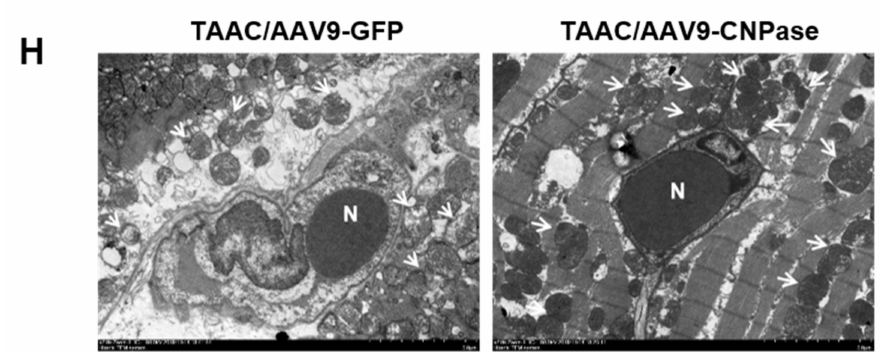
Figure 4. Myocardial CNPase delivery protects the heart from pressure overload-induced cardiomy- opathy. ( A , B ) Effects of CNPase overexpression on the heart weight to body weight (HW/BW) ratio and the heart weight to tibia length (HW/TL) ratio. ( C – E ) Effects of CNPase overexpression on the heart hypertrophy and cardiomyocyte size. Representative images of heart cross sections by hematoxylin and eosin (H and E) staining and quantitative analysis. Original magnifications, D Â 400. ( F , G ) Representative images of Masson’s Trichrome stained heart sections and quantification analysis. The pressure overload-induced heart hypertrophy was carried out by transverse abdominal aorta constriction (TAAC) surgery. ( H ) Representative transmission electron micrographs of mitochondria from the left ventricular myocardium in the AAV9-vehicle/TAAC and AAV9-CNPase/TAAC groups. Arrows indicating the representative mitochondria, scale bar, 5 µ m. N, nucleus. The AAV9-CNPase vectors (1 × 10 12 genome copies) were delivered into the left ventricular myocardium guided by echocardiography. n = 8 in the sham group, n = 14 in the TAAC-GFP group, n = 16 in the TAAC- AAV-CNPase group. One-way ANOVA, Tukey’s multiple comparisons test, *, p < 0.05; **, p < 0.005; ***, p <